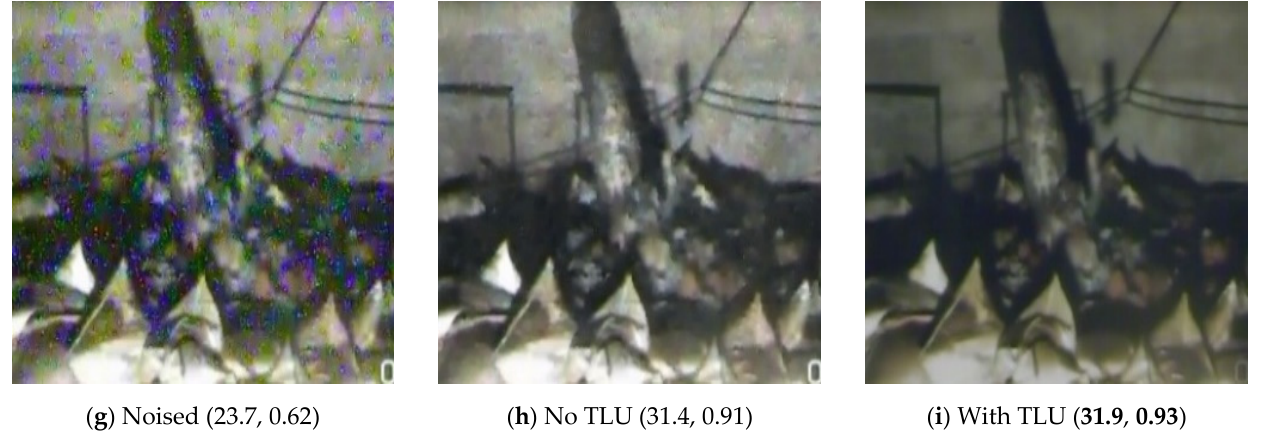
Figure 12. Denoising results of our network with and without the TLU. The first column containing ( a , d , g ) is the original noised images; the second column containing ( b , e , h ) is the denoised results of the model without the TLU; the third column containing ( c , f , i ) is the denoised results of the model with the TLU. There is a value tuple under each subfigure. The first value in the tuple is the PSNR calculated with the ground truth clean image, and the second number in the tuple is the SSIM. For each scene, the best quantitative results are marked in boldface.